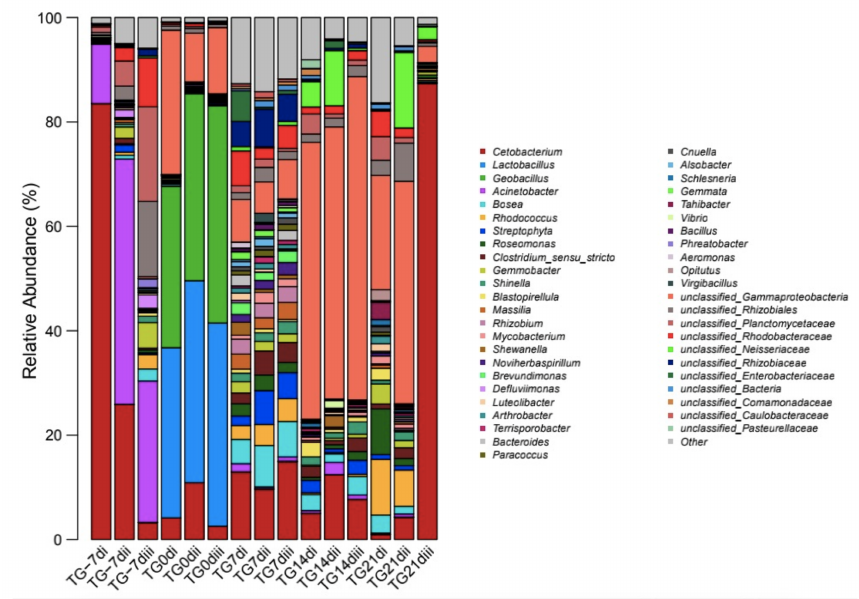
Figure 4. Bar plot illustrating the relative higher abundance bacterial genera for the individual fish. TG: treatment group: − 7, 0, 7, 14 and 21 d represent the sample time points; i, ii, and iii represent individual triplicates within a group.